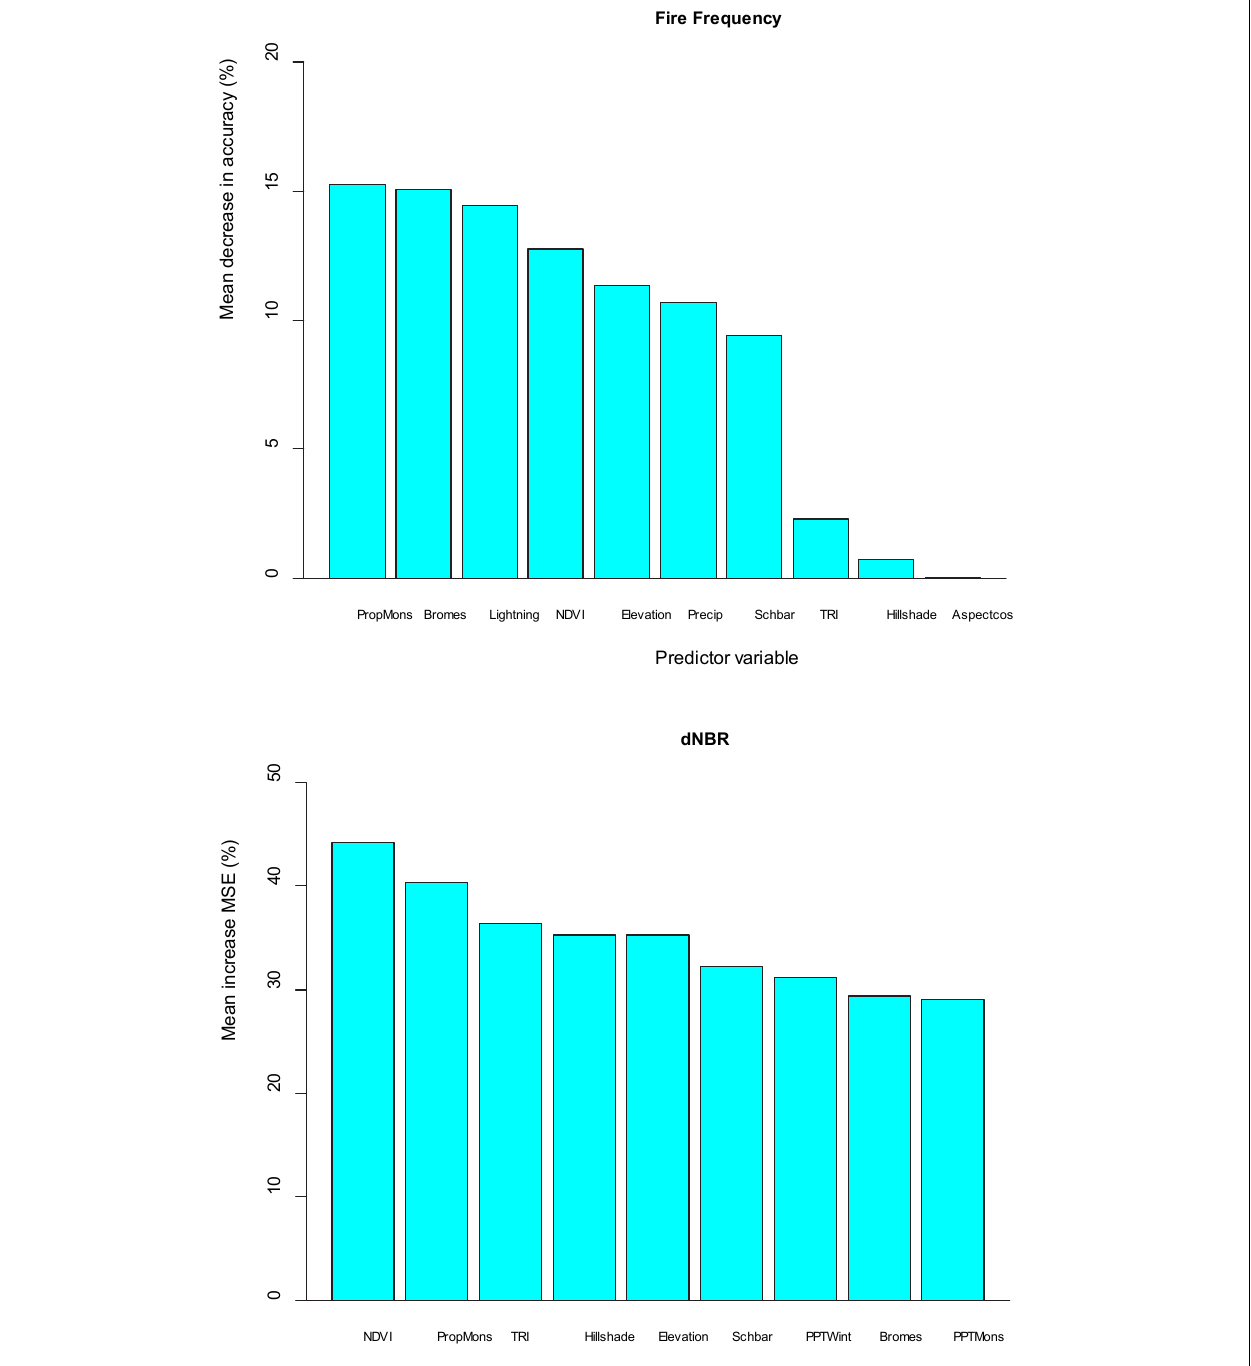
spread as well as a larger scale one of elevation on fuel loads and fire spread. There is a strong positive correlation between TRI and slope, and fuel loads and steeper terrain tend to be